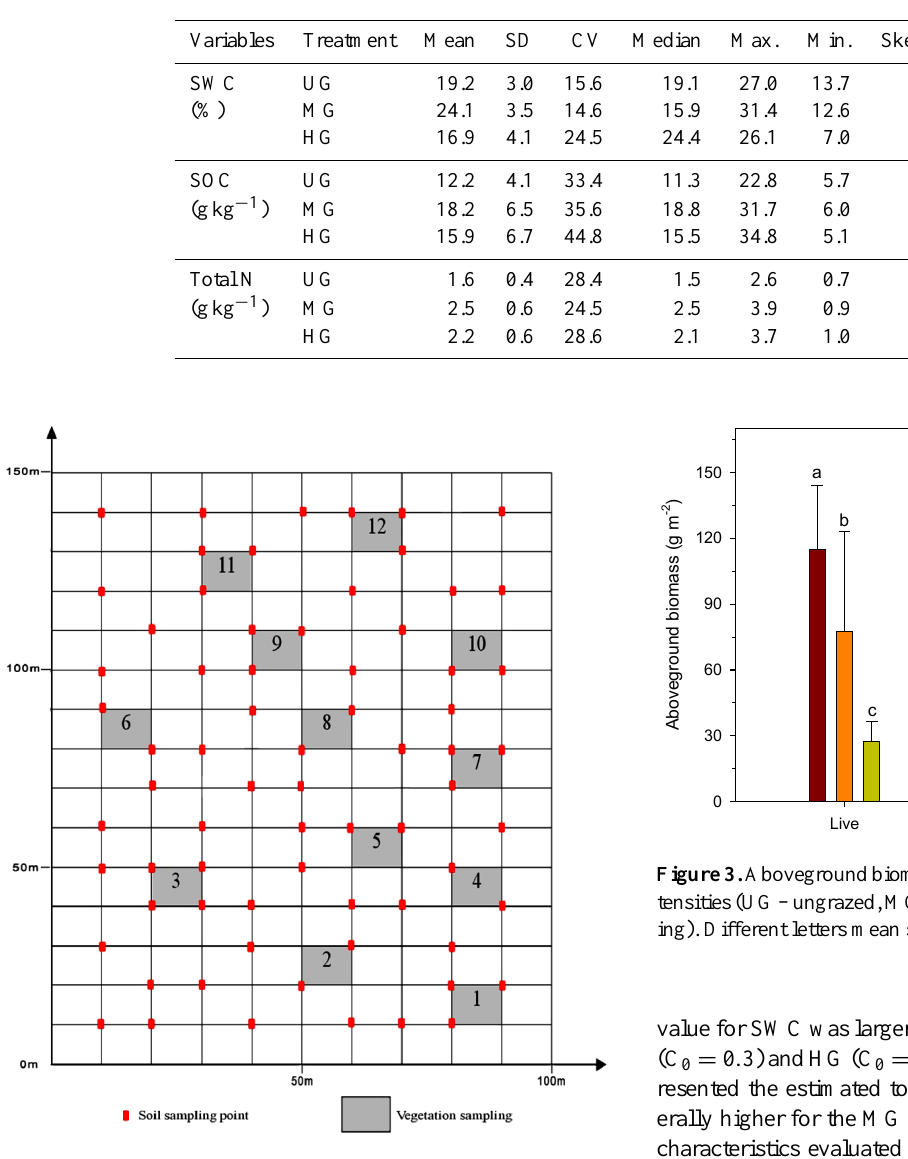
Figure 2. Soil and vegetation sampling points at one of the study sites.